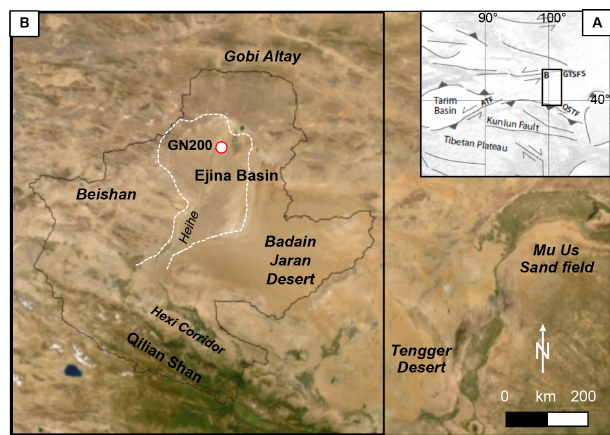
Figure 1. (a) The study site is located in an area dominated by left-lateral transpression due to the ongoing India–Eurasia colli- sion. GTSFS = Gobi Tien Shan fault system, QSTF = Qilian Shan thrust front, ATF = Altyn Tagh fault. (b) White dotted line: Heihe fan covering much of the Ejina Basin. Black line: Heihe catchment. GN200 marks the coring site. (Service layer credits: Esri, Digital- Globe, GeoEye, Earthstar Geographics, CNES/Airbus DS, USDA, USGS, AeroGRID, IGN, and the GIS User Community. The map was created using ArcGIS ® software. ArcGIS ® is the intellectual property of Esri and is used herein under licence.